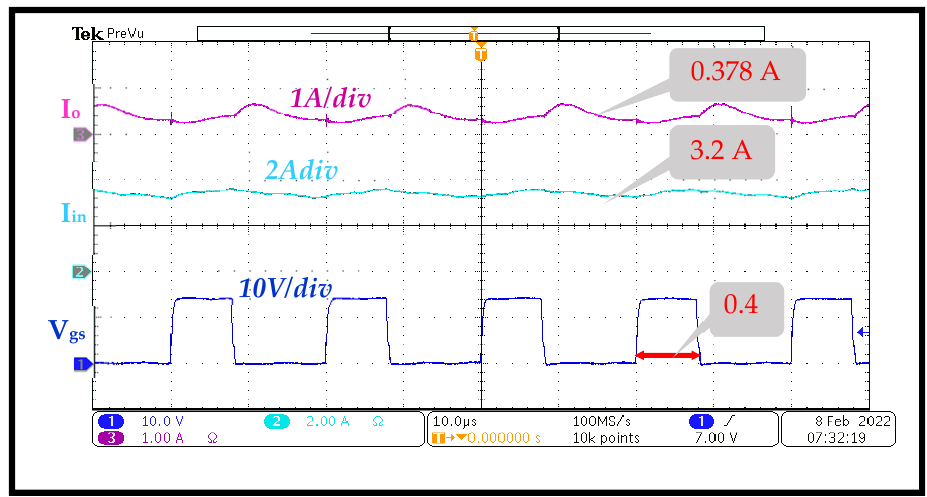
Figure 24. The experimental waveform of ( 1 ) Duty cycle (V gs ) at d = 0.4, ( 2 ) Input Current (I in ), ( 3 ) Output Current (I 0 ).